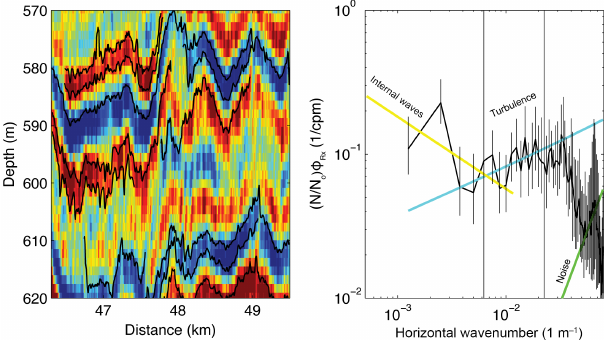
Figure 8. Tracks of seismic data and displacement spectra with 95% bootstrap confidence intervals (vertical bars) of the repre- sentative window over which scaling from relative turbulent en- ergy to estimates of diffusivity are calculated. At this scale, the same wavenumber subrange exhibits the characteristic slope of tur- bulence (cyan line). This segment yields an average diffusivity of 9.0 × 10 − 5 m 2 s − 1 with a 95% confidence range of 5.6 × 10 − 5 – 1.5 × 10 − 4 m 2 s − 1 . Characteristic slopes of internal waves (GM77) and noise (KM07b) are shown in yellow and green.